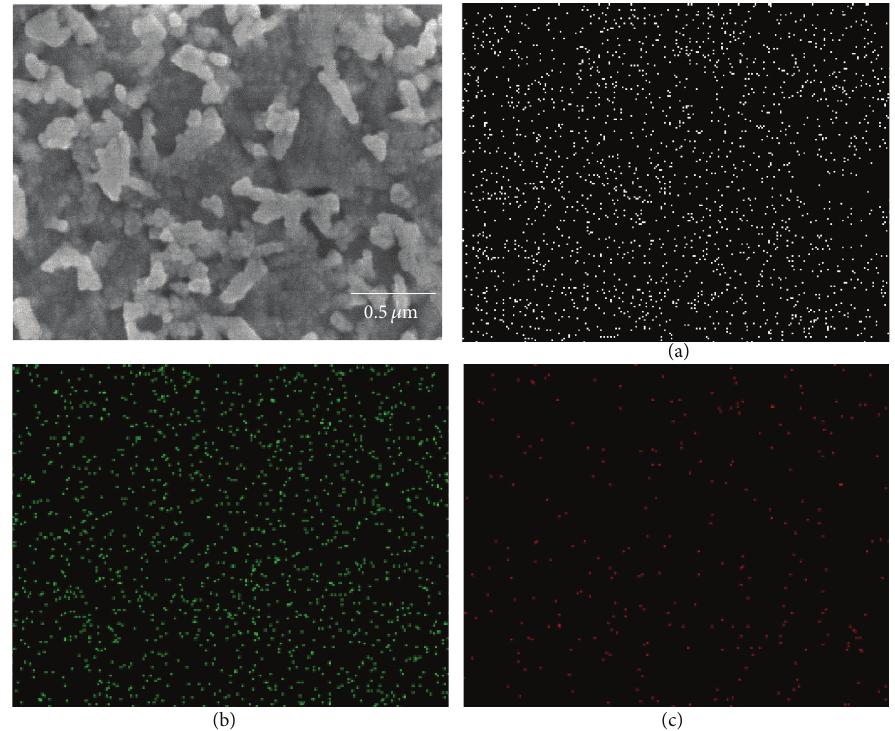
Figure 5: EDS mapping result of WC-3 wt% Ni sintered